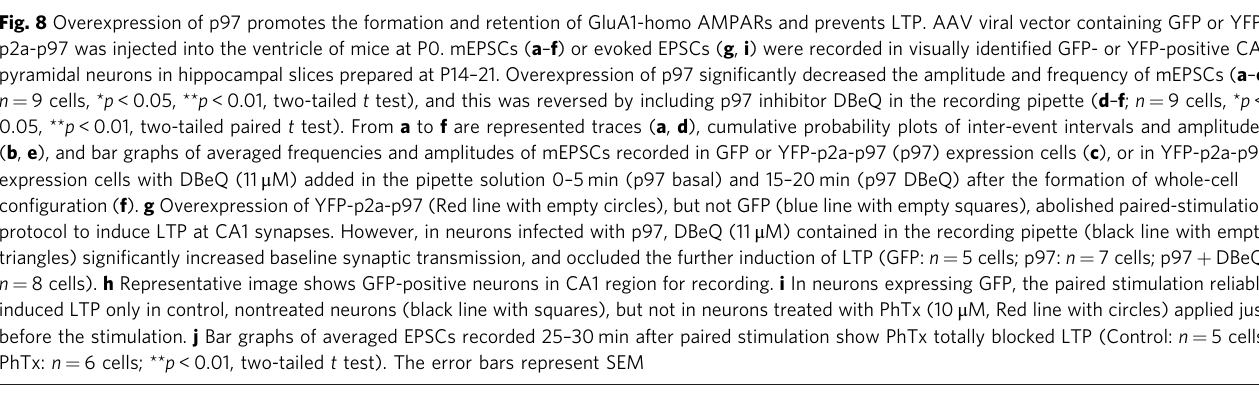
Fig. 8 Overexpression of p97 promotes the formation and retention of GluA1-homo AMPARs and prevents LTP. AAV viral vector containing GFP or YFP- p2a-p97 was injected into the ventricle of mice at P0. mEPSCs ( a – f ) or evoked EPSCs ( g , i ) were recorded in visually identi fi ed GFP- or YFP-positive CA1 pyramidal neurons in hippocampal slices prepared at P14 – 21. Overexpression of p97 signi fi cantly decreased the amplitude and frequency of mEPSCs ( a – c ; n = 9 cells, * p < 0.05, ** p < 0.01, two-tailed t test), and this was reversed by including p97 inhibitor DBeQ in the recording pipette ( d – f ; n = 9 cells, * p